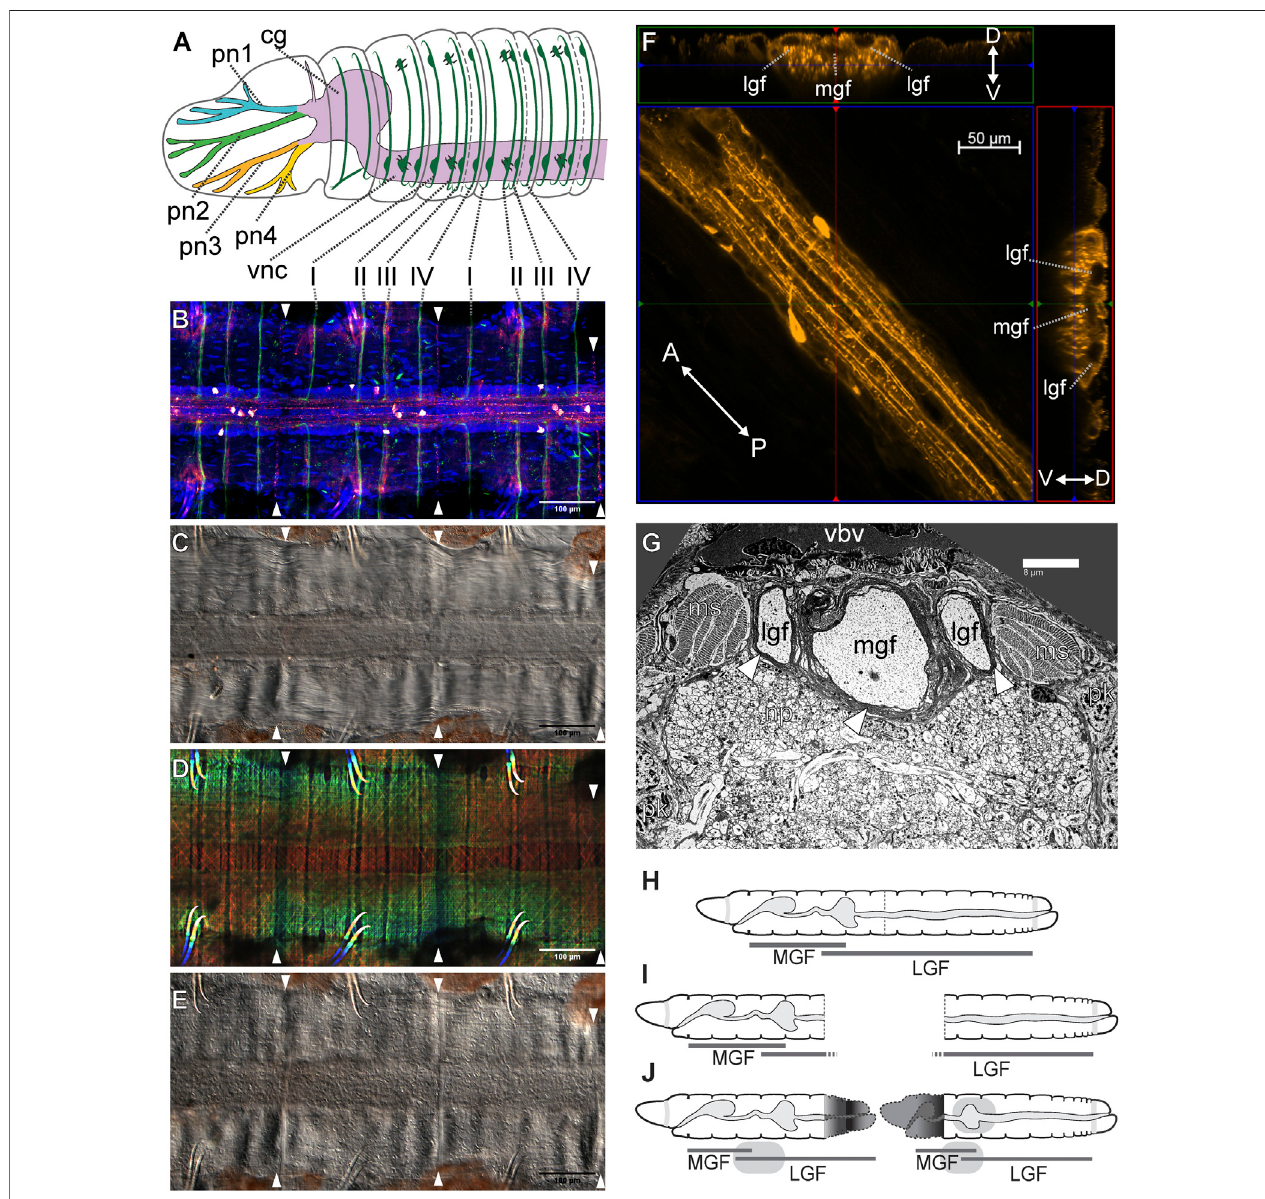
FIGURE 2 | Lumbriculus nervous system morphology and sensory fi eld regeneration. (A) Schematic representation of the anterior nervous system, showing the ventral nerve cord (vnc), dorsal cerebral ganglion (cg), prostomial nerves (pn1-4) and segmental peripheral nerves (I – IV). (B – E) Ventral nerve cord and peripheral nerve roots; all panels show the same whole-mounted specimen, oriented anterior to the left; arrowheads point at the segmental fi ssion planes. (B) Confocal image of immunohistochemicallabelingofacetylatedtubulin(green)andserotonin(red-white);DNAcounterstain(blue)showscellnuclei. (C) Differentialinterferencecontrast (DIC) image showing the main neuropil of the nerve cord fl anked by muscle bands. (D) Depth coded confocal stack of phalloidin-labeled F-actin showing longitudinal, circular and diagonal muscle fi bers. (E) DIC image showing theepidermis. (F) Confocal stack showing a stretch ofnerve cord immunolabeledagainst serotonin (center); thelateralsaretwovirtualZ-sectionsshowingthemedial(mgf)andlateralgiantnerve fi bers(lgf).Thedouble-headedarrowsshowtheanterior(A)/posterior (P)anddorso (D)/ventral(V)orientationinthecenterandlateralpanelsrespectively. (G) Transmissionelectronmicroscopyimageofathintransversesectionintheanteriorregionofthe nerve cord, showing the medial (mgf) and lateral giant nerve fi bers (lgf) surrounded by myelin-like sheaths (arrowheads); ms: muscle bundle; np: neuropil; pk: perikaryon (neuronal cell body); vbv: ventral blood vessel. (H – J) Reestablishment of the anterior medial giant fi ber (MGL) and posterior lateral giant fi ber (LGL) sensory fi elds after amputation and regeneration. (H) Intact worm. (I) Amputated worm fragments. (J) Regenerated fragments redrawn after Isossimow (1926), color/nerve nomenclature after Zattara and Bely (2015).